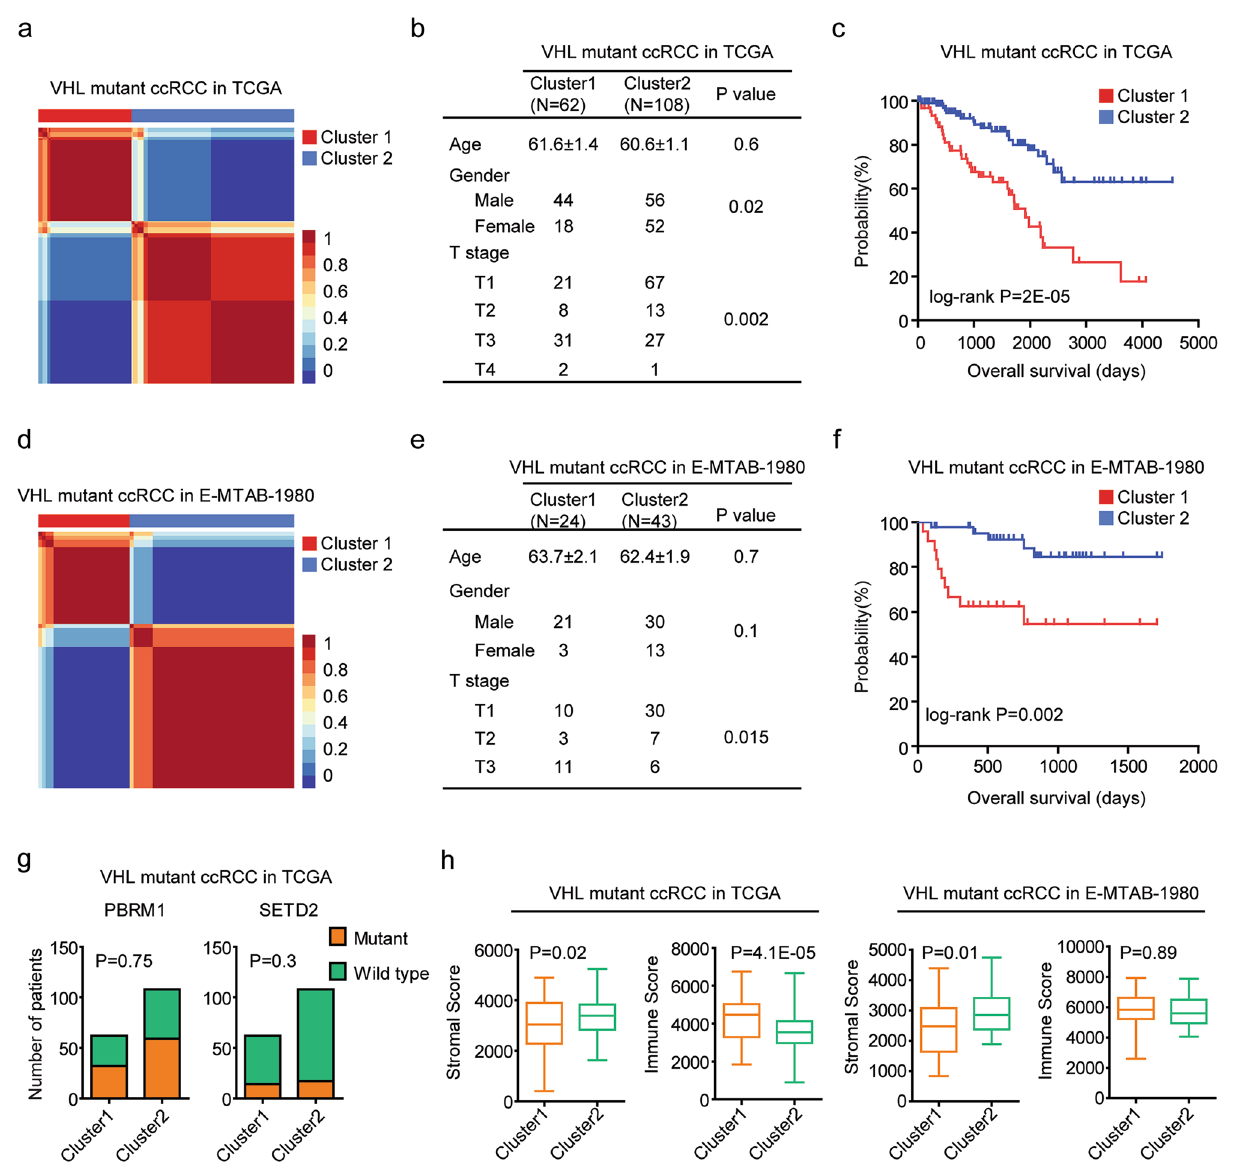
Figure 1. Two molecular sub-clusters of VHL mutant ccRCC patients with different clinical outcomes. ( a ) Consensus-map showed that primary ccRCC patients with VHL mutations from TCGA dataset were divided into two sub-clusters using NMF method. ( b ) Table showed the different clinical characteristics of VHL mutant ccRCC patients in sub-cluster1 and sub-cluster2 in TCGA dataset. ( c ) Kaplan–Meier survival plot showed the different overall survival of VHL mutant ccRCC patients in sub-cluster1 and sub-cluster2. P value was determined by log-rank test. ( d ) Primary ccRCC patients with VHL mutations from E-MTAB-1980 dataset were divided into two sub-clusters using NMF method. ( e ) Table showed the different clinical characteristics of VHL mutant ccRCC patients in sub-cluster1 and sub-cluster2 in E-MTAB-1980 dataset. ( f ) Kaplan–Meier survival plot showed the clinical outcomes of sub-cluster1 and sub-cluster2 VHL mutant ccRCC patients in E-MTAB-1980 dataset. ( g ) The number of VHL mutant ccRCC patients with or without PBRM1 or SETD2 alterations in each sub-cluster of TCGA dataset. P values were calculated by Chi-square test. ( h ) Box plots showed the stromal scores and immune scores in sub-cluster1 and sub-cluster2 VHL mutant ccRCC patients in TCGA and E-MTAB-1980